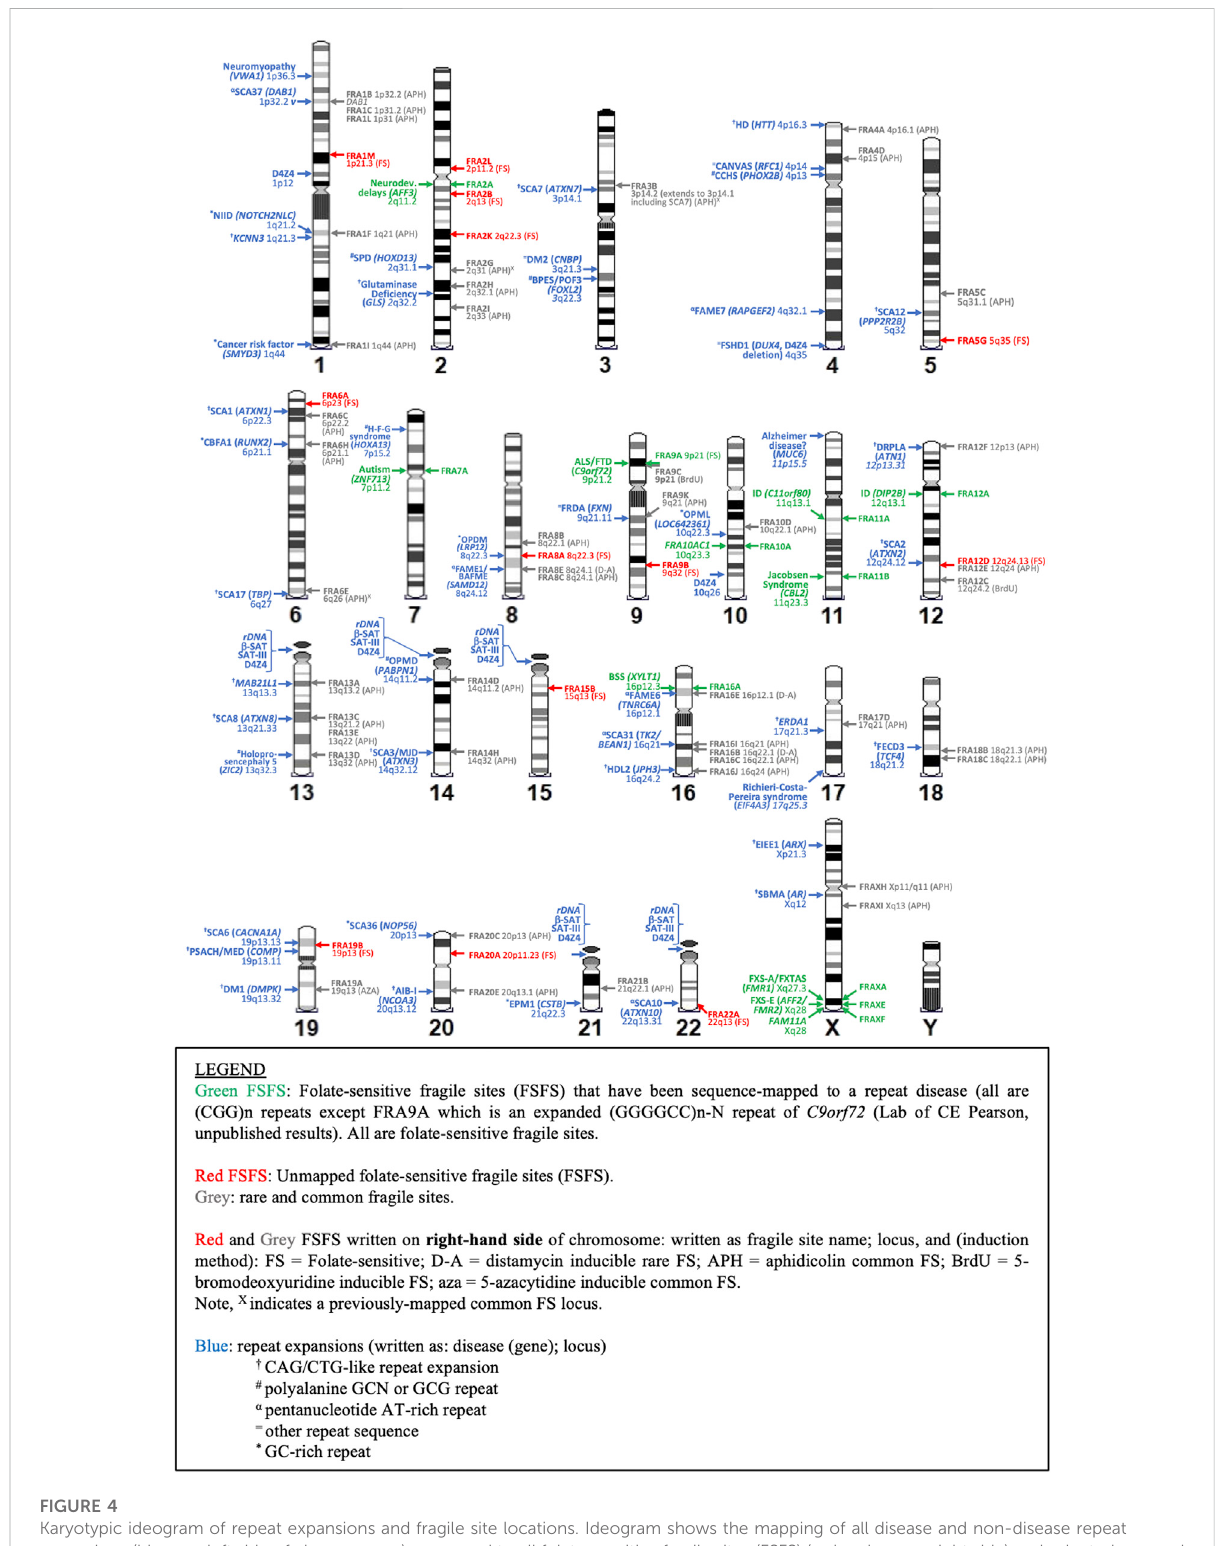
FIGURE 4 Karyotypic ideogram of repeat expansions and fragile site locations. Ideogram shows the mapping of all disease and non-disease repeat expansions (blue; on left side of chromosome) compared to all folate sensitive fragile sites (FSFS) (red and green; right side) and selected rare and common FS near disease loci (gray; right